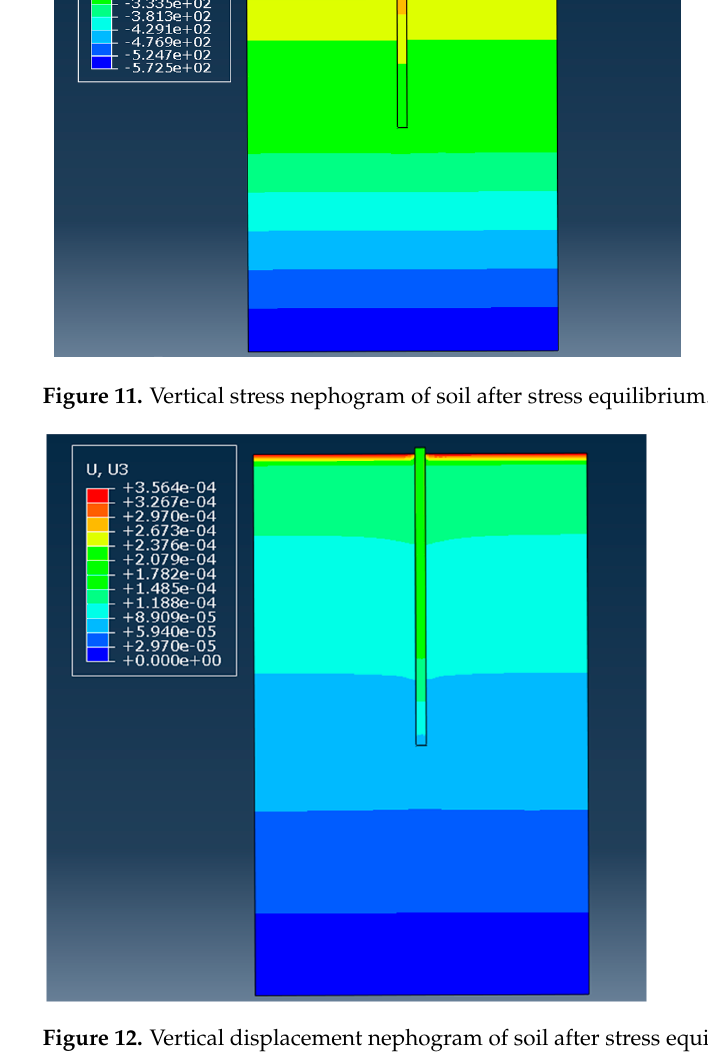
Figure 11. Vertical stress nephogram of soil after stress equilibrium.